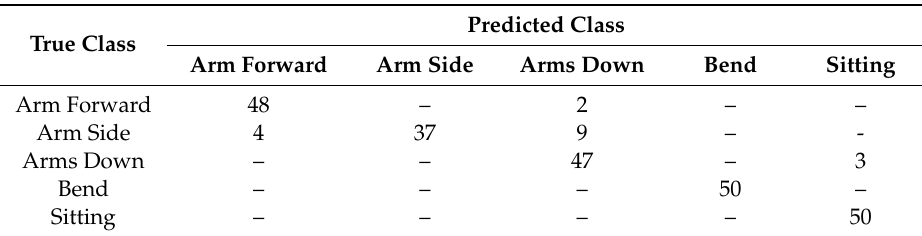
Table 9. Confusion matrix generated from implementing the Soft Voting approach to prediction selection for four corner TISs.